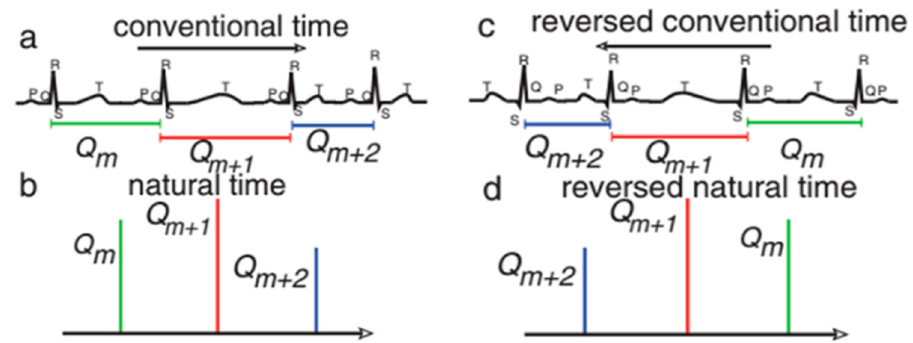
Figure 7. ( a ) ECG in which the RR distances are marked; ( b ) the same ECG plotted in ( a ) but read in Natural Time Analysis (NTA); ( c ) ECG at conventional time upon time reversal; ( d ) ECG upon time reversal in NTA.